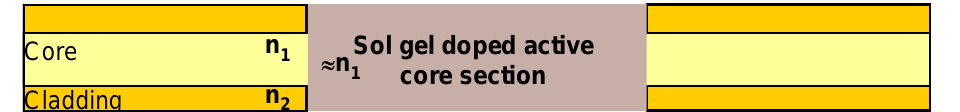
Figure 12. Active core optical fiber sensor.